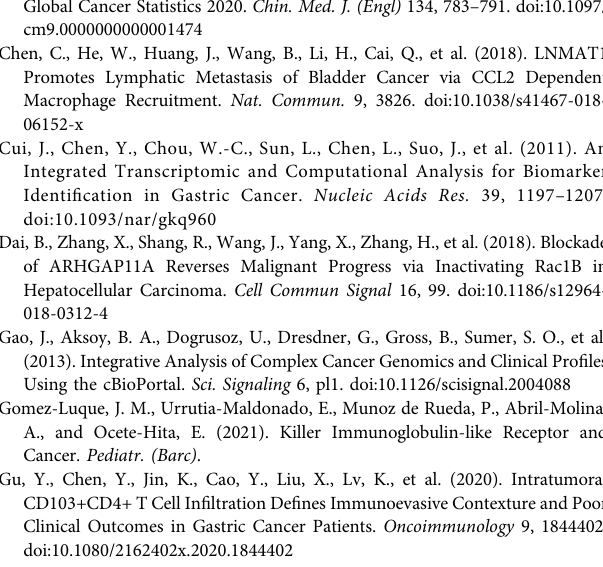
Supplementary Figure 1 | Cytoplasmic expression of ARHGAP11A in various types of cancer. Supplementary Figure 2 | Genetic alterations of ARHGAP11A in gastric cancer from TCGA database. Supplementary Figure 3 | The overall survival of gastric cancer patients with/ without ARHGAP11A alteration. SupplementaryFigure4 |Thedisease-freesurvivalofgastriccancerpatientswith/ without ARHGAP11A